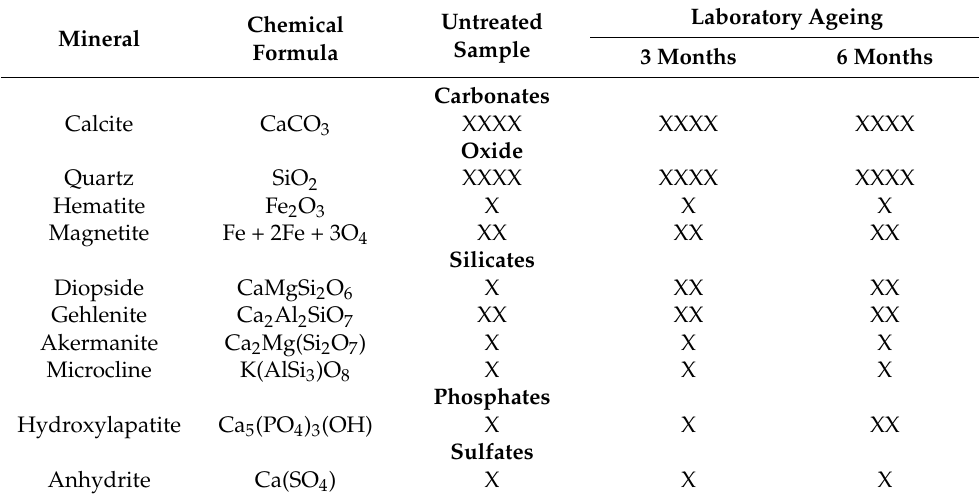
Figure 7. Amounts of heavy metals in different bottom ash fractions during natural weathering (mg/kg): Mn; Cu; Zn; Pb; Sr. Table 3. Mineral compositions of untreated BA and BA after 3- and 6-month laboratory aging.